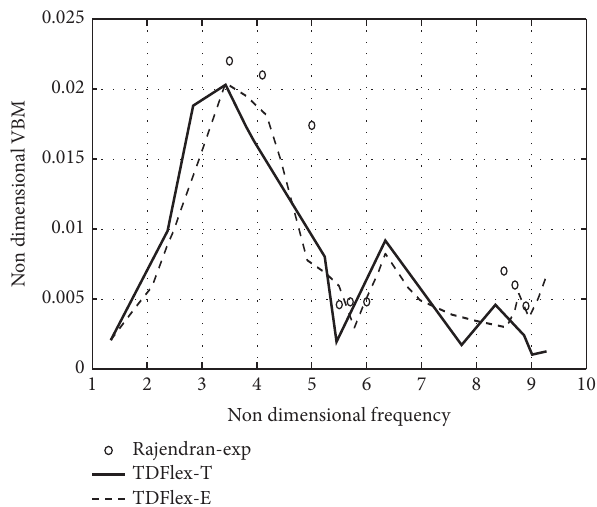
Figure 9: Comparison of rigid body and hydroelastic RAO of vertical deflection for the ULC at L/4.